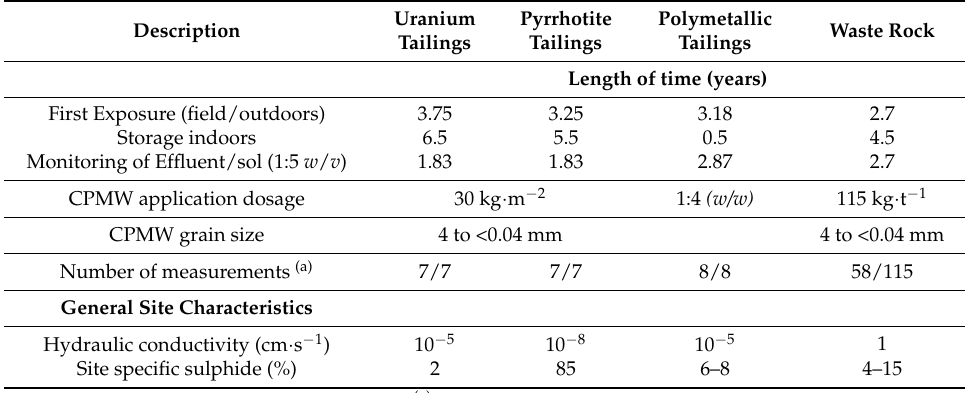
Table 1. Summary of experimental timelines and characteristics of sulphidic tailings and waste rock (both data extracted from